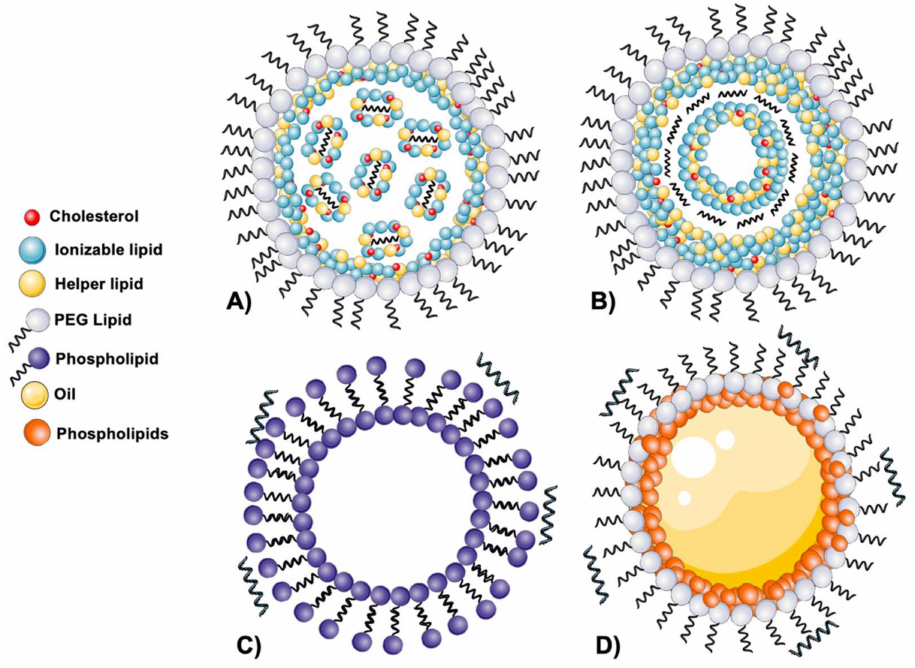
Figure 3. Lipid delivery vehicles for mRNA delivery. ( A ) Lipid nanoparticles (LNPs), structure proposed [87]; ( B ) Lipid nanoparticles (LNPs), structure proposed. Reproduced from Viget et al. [86] which is licensed under a Creative Commons Attribution-(CC BY 4.0) International License (http: //creativecommons.org/licenses/by/4.0/); ( C ) Lipoplexes (LPX) and ( D ) cationic nanoemulsions